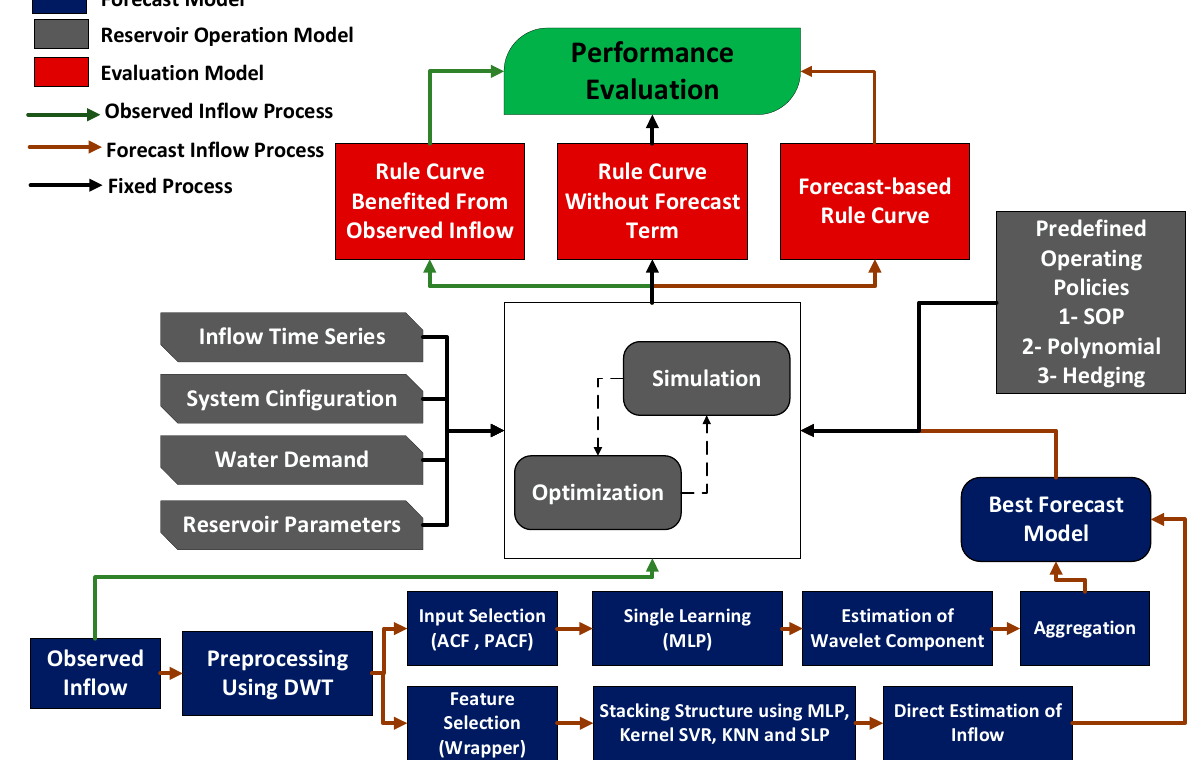
Figure 1. Flowchart of the proposed models .